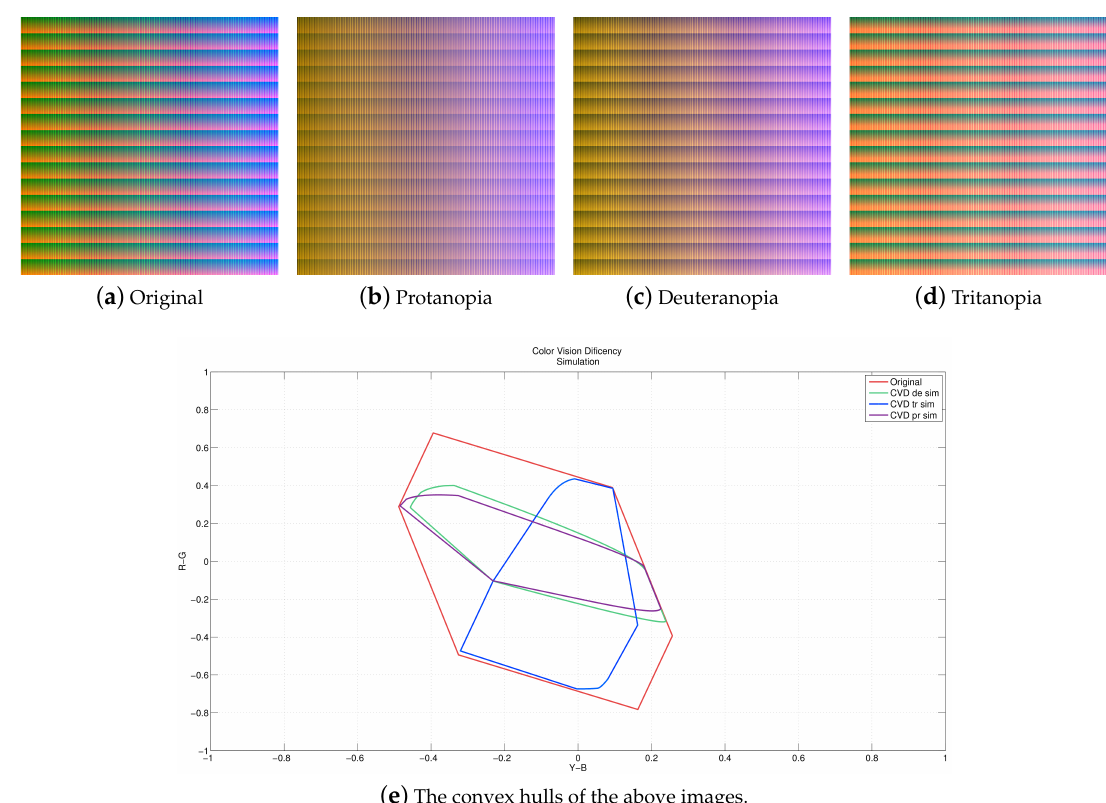
Figure 9. ( a ) Three types of color vision deficiency simulation using a full-color image with 256 3 pixels. The image resolution is 4096 × 4096. ( e ) The convex hulls of the images in (a–d). All types of CVD simulation cover only a part of the convex hull of the original full color